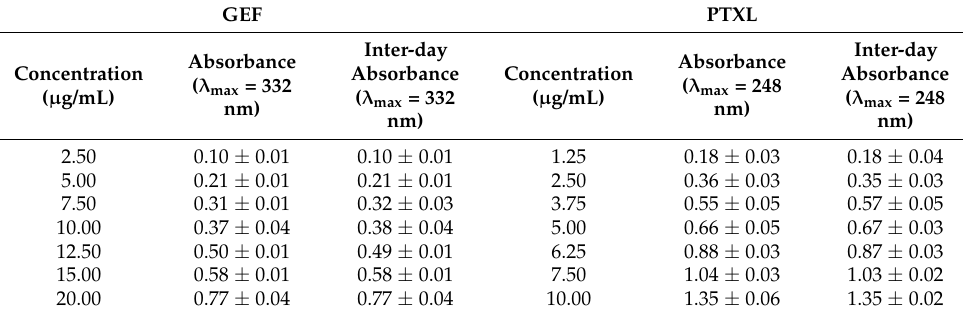
Table A2. Absorbances and inter-day absorbances for simultaneous estimation of GEF and PTXL at various concentrations. Absorbances are expressed as mean ± SD.